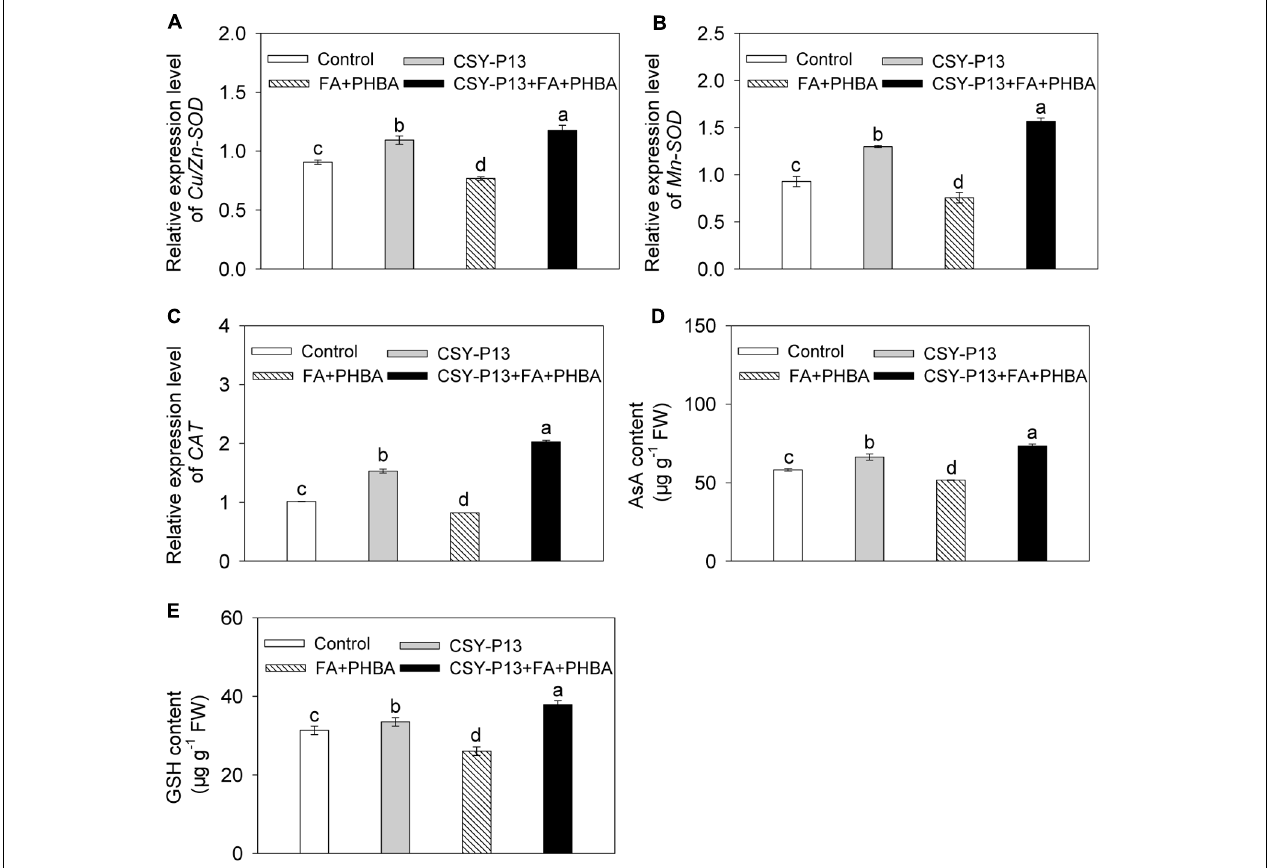
FIGURE 6 | Effects of CSY-P13 and the mixture of FA and PHBA on transcript levels of Cu/Zn-SOD (A) , Mn-SOD (B) , and CAT (C) , and contents of AsA (D) and GSH (E) in cucumber leaves. Bars represent standard errors of three biological replicates. Values with the different letters are significantly different at P < 0.05 by LSD test using SPSS for Windows 22.0 software (IBM Corp., Armonk, NY, United